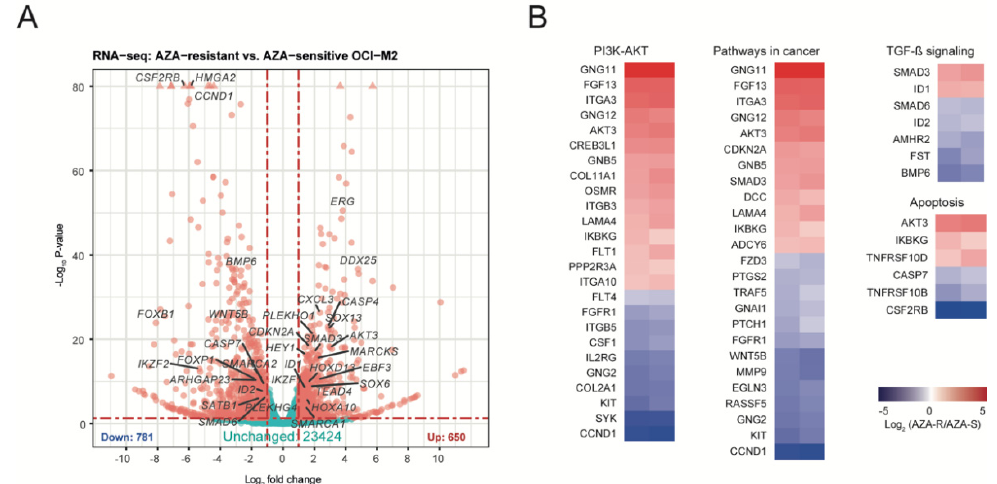
Figure 2. Transcriptomic analysis of cells either resistant or sensitive to AZA. ( A ) Volcano plot of differential gene expression; significance indicated by adjusted p < 0.05; log2 fold change expression > 1 is marked by red. Selected mRNAs are displayed with HGNC symbol. ( B ) Heatmaps show mRNA expression log2(AZA-R/AZA-S) in two replicates as revealed by KEGG pathway analysis.